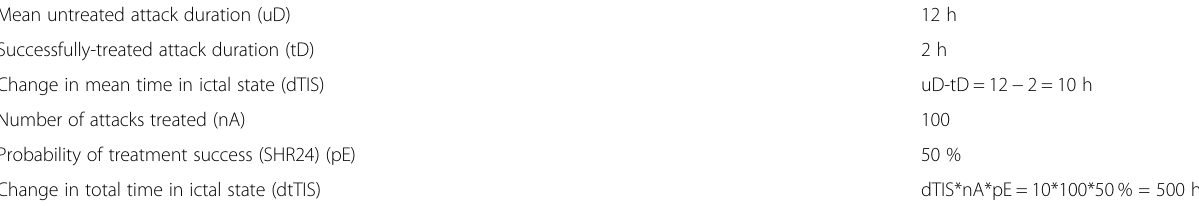
Table 1 Imaginary numerical example of acute treatment effect in a population Mean untreated attack duration (uD) 12 h Successfully-treated attack duration (tD) 2 h Change in mean time in ictal state (dTIS)